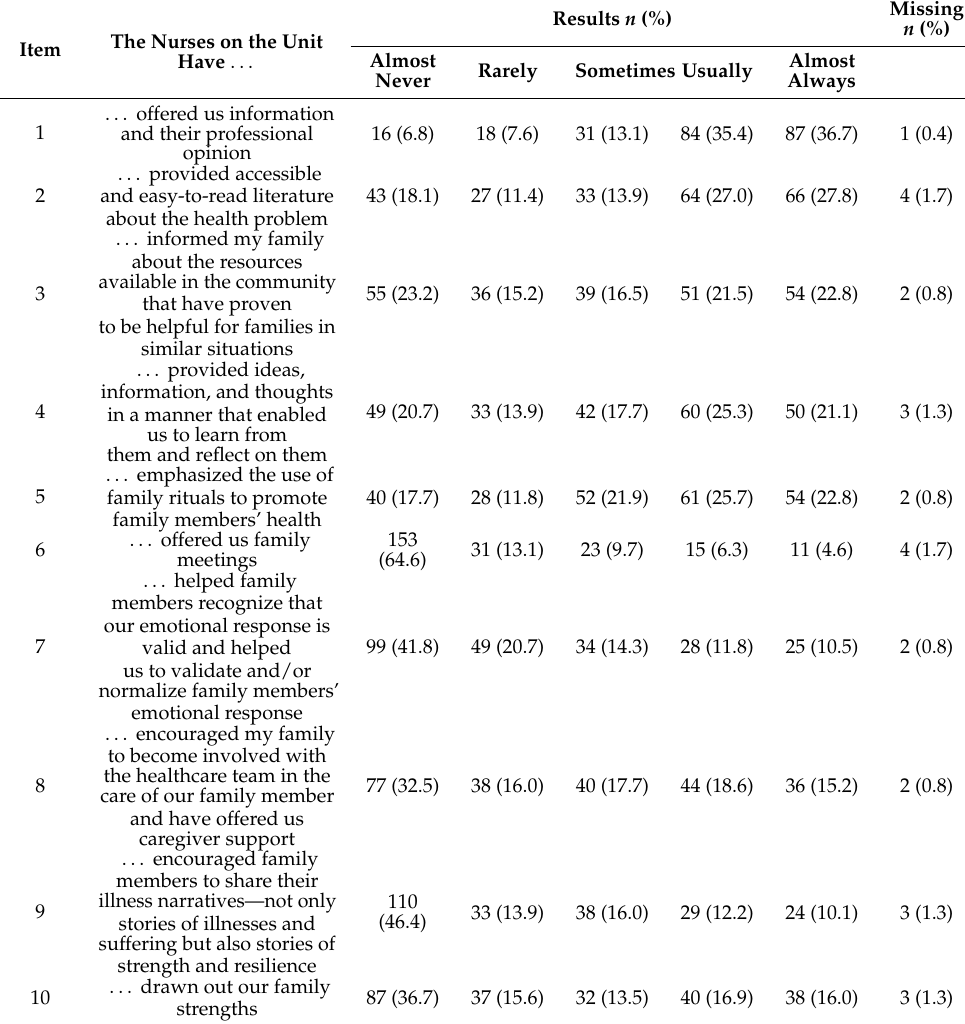
Table 2. Response Frequencies to the Items of the Portuguese version of ICE-FPSQ ( n = 237).